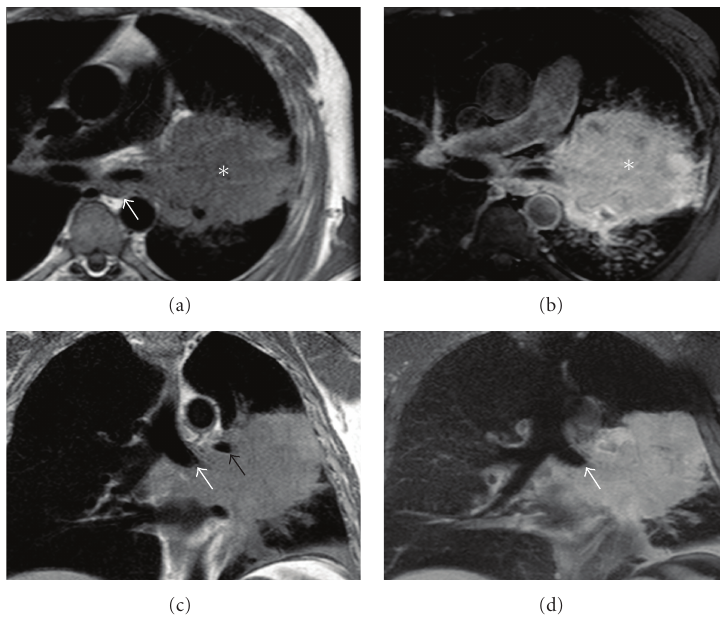
Figure 4: Bronchogenic carcinoma. A large mass (asterisk) is shown in axial ((a) and (b)) and coronal ((c) and (d)) planes. On T1-weighted images the mass demonstrates significant near-uniform enhancement after gadolinium contrast ((a) and (c) before contrast; (b) and (d) after contrast). The mass infiltrates posterior to the carina ((a), white arrow) and occludes the left main bronchus ((c) and (d), white arrow). The left main pulmonary artery is severely attenuated ((c), black arrow).